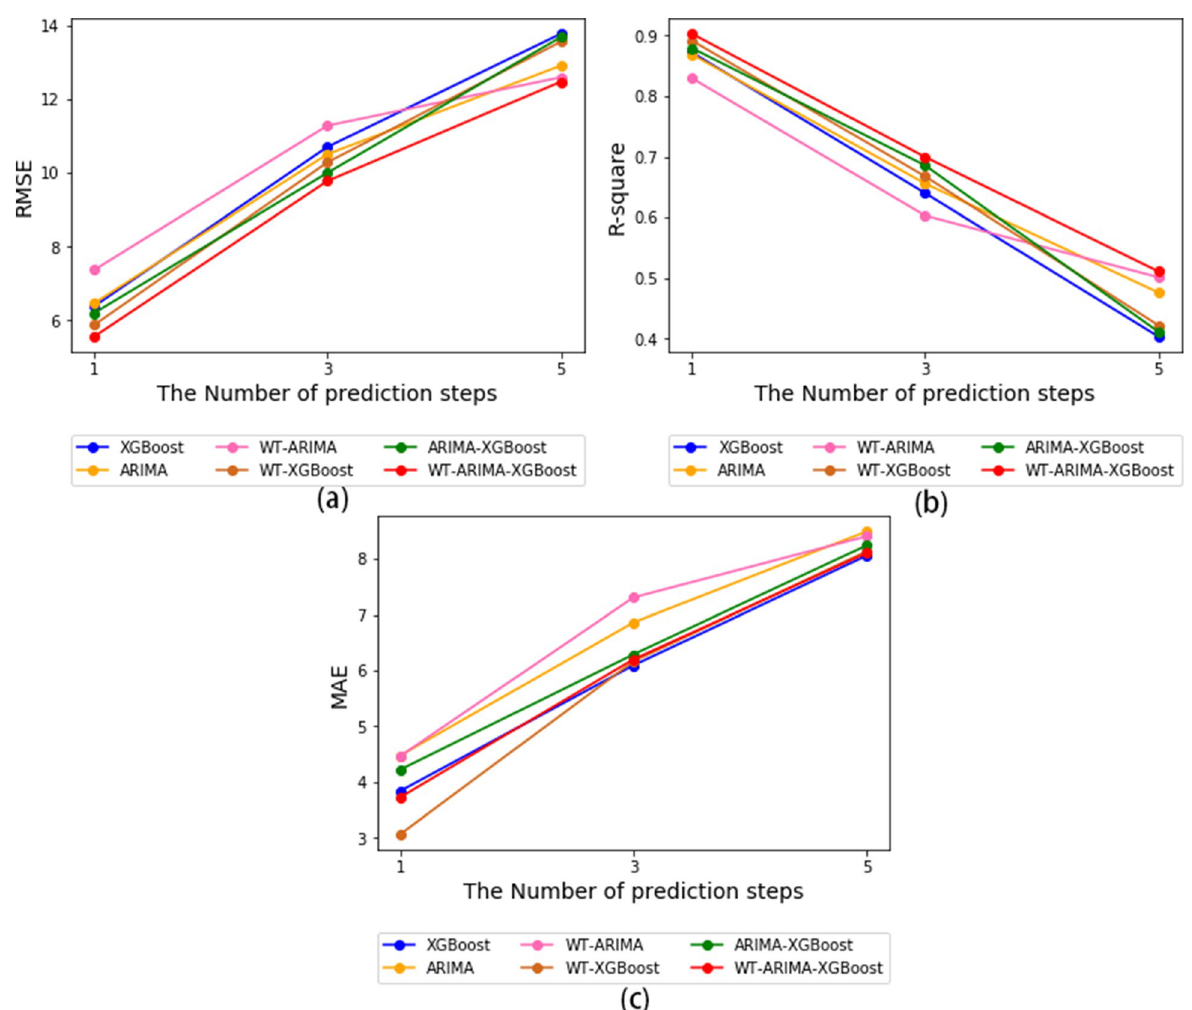
Bold means that this model achieves the best results for this metric in this case compared to other